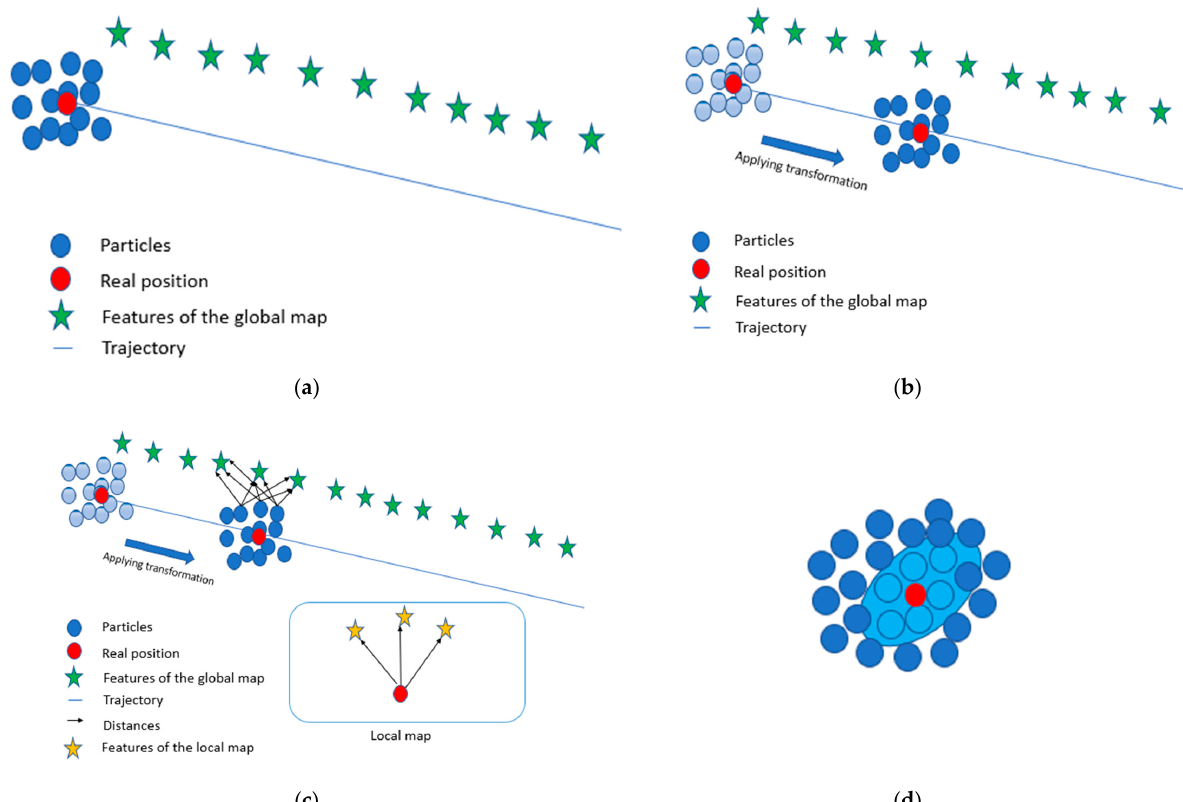
Figure 4. Explanation of the workflow of the particle filter (the images are not real; they are generated to explain the process in depth). ( a ) Generate particles. ( b ) Applying IMU transformation. ( c ) Compare the distances of the particles with the futures of the global map (features in green) and the real distance. ( d ) Resampling stage, where we regenerate particle around the closest one (particle in-cyan color)